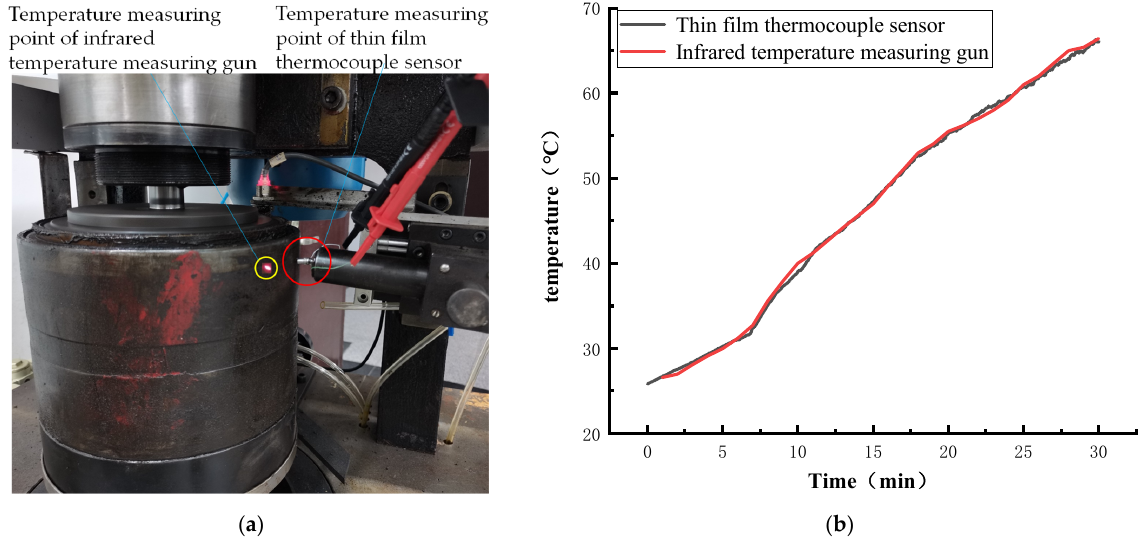
Figure 12. Comparative temperature measurement test: ( a ) location of temperature measuring point; ( b ) temperature comparison diagram.